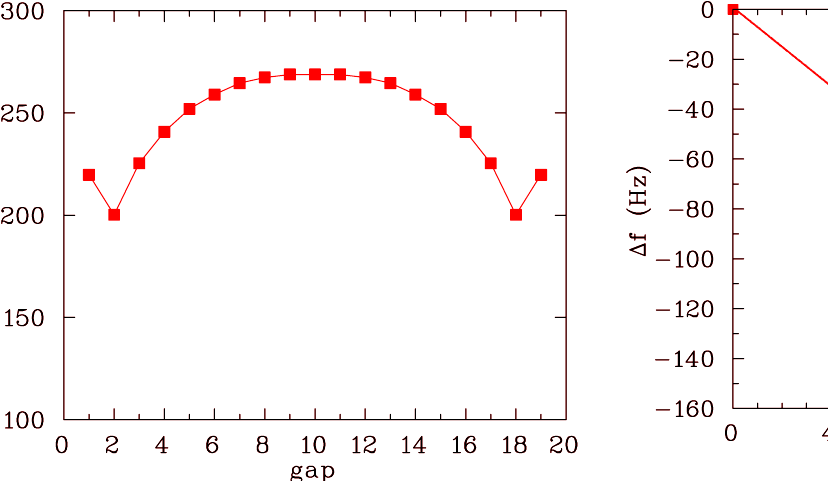
FIG. 36. (Color) Measured frequency shift due to Lorentz force detuning (gradient based on (cid:1)(cid:2) definition).